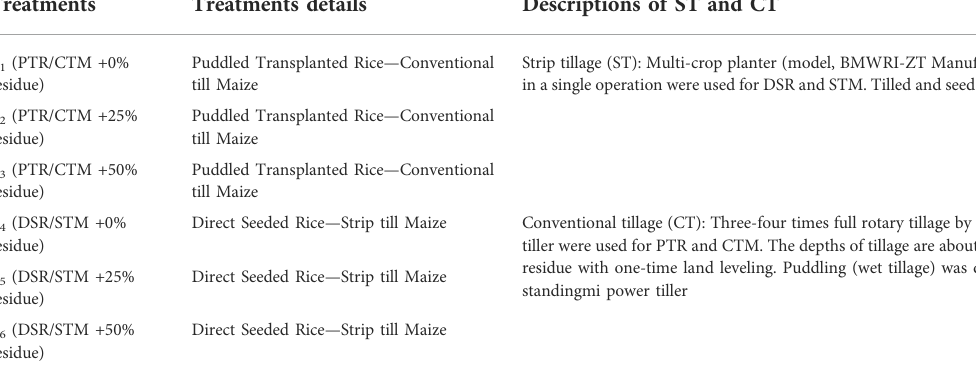
TABLE 2 Description of experimental treatments. Treatments Treatments